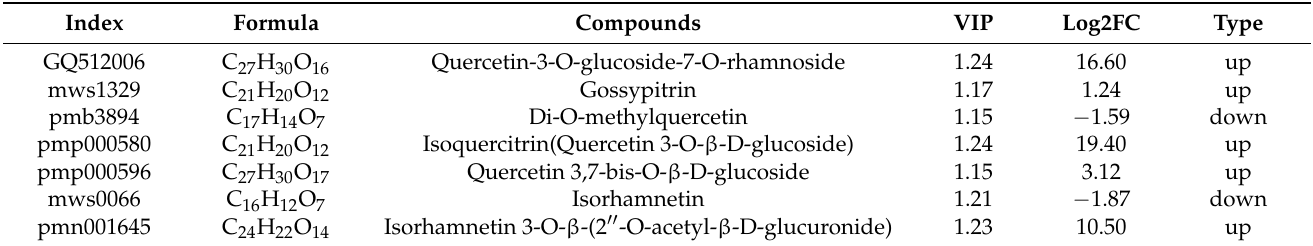
Table 1. Differential metabolites associated with flavonoid synthesis within the roots and leaves of mature A. ilicifolius .